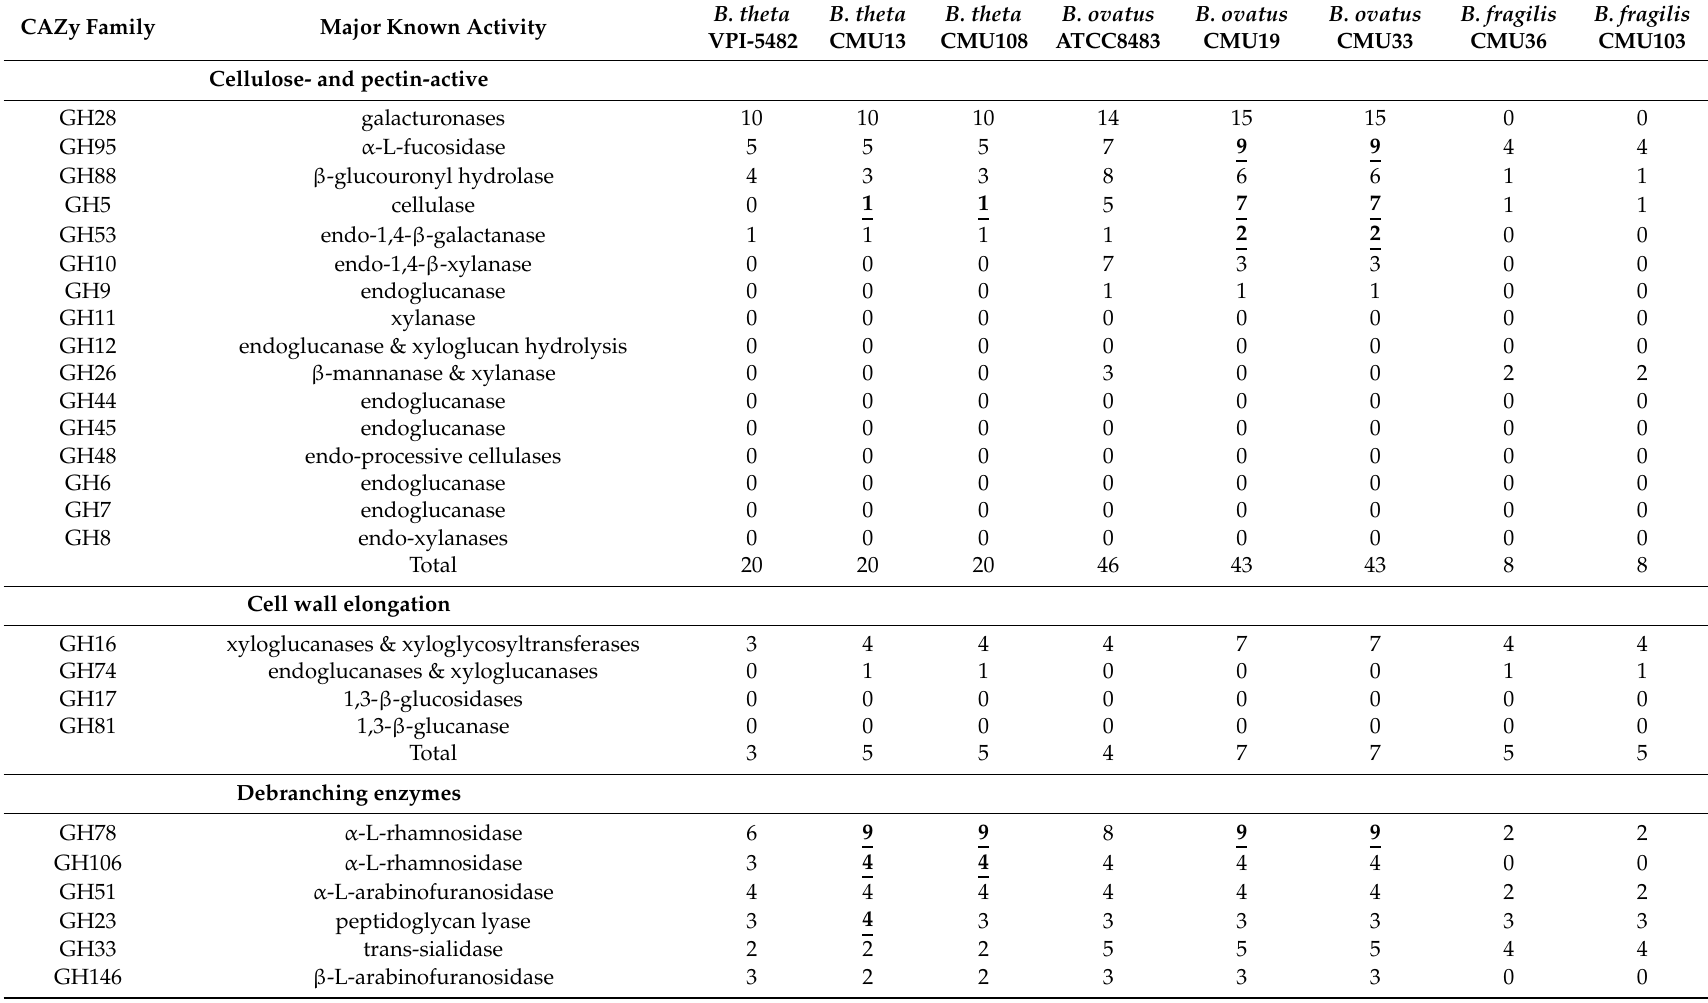
Table 3. CAZome of bacterial isolates for the major glycoside hydrolase (GH) families involved in degradation of plant cell walls. CAZy